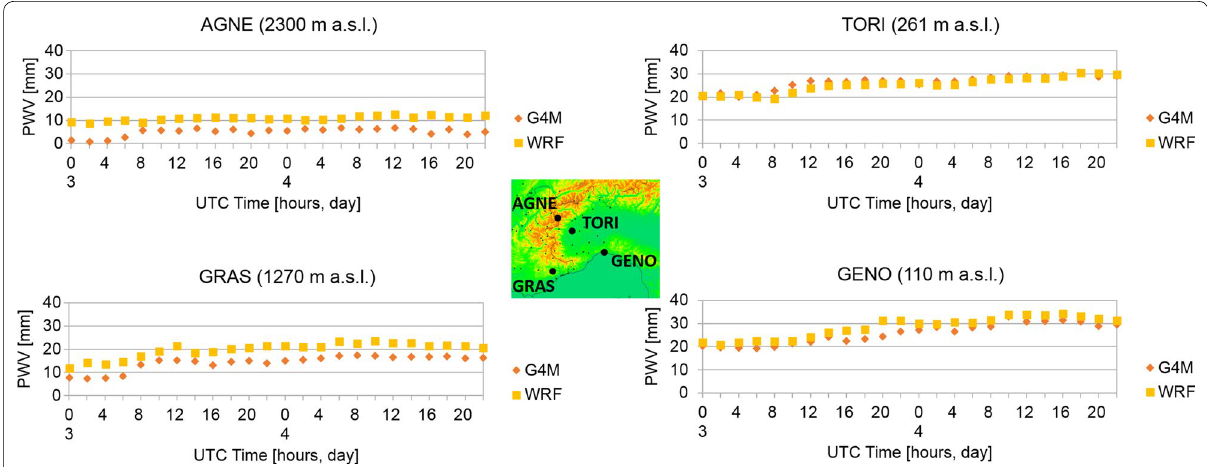
Fig. 5 Two-hour PWV time series for November 3–4, 2011, for the GENO, TORI, GRAS, and AGNE GNSS PSs